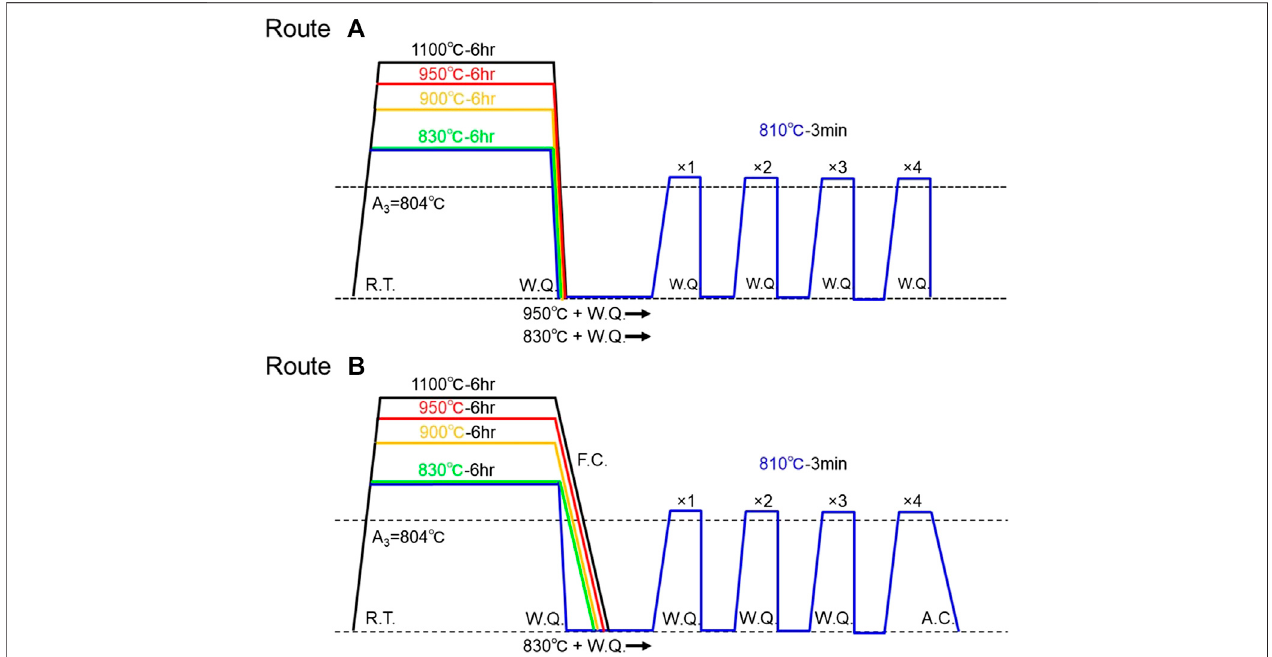
FIGURE 1 | Schematic representations showing the heat treatment routes to obtain austenite microstructures with different grain sizes [route (A) ] and ferrite + pearlite (F + P) microstructures with different ferrite grain sizes [route (B) ] in the 2Mn-0.1C steel. In the route (A) , fi nal microstructures at room temperature were